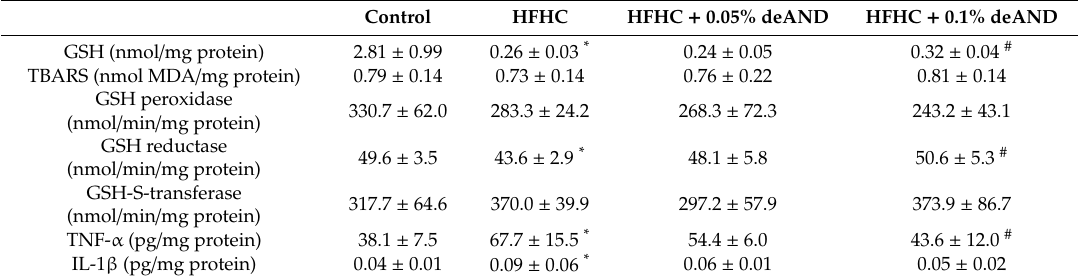
Table 4. GSH, GSH-related enzyme activities, lipid peroxidation, and inflammation in mice liver a .